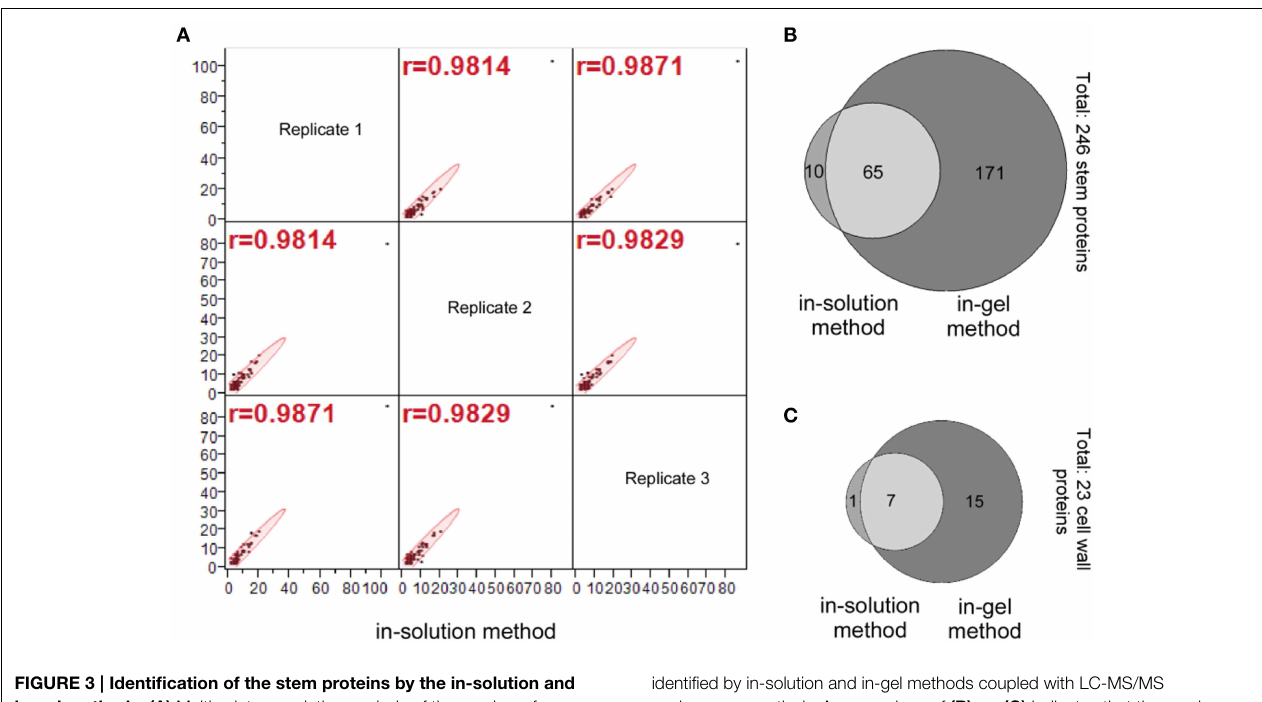
FIGURE 3 | Identification of the stem proteins by the in-solution and in-gel methods. (A) Multivariate correlation analysis of the number of peptide hits for the 75 stem proteins that identified by the in-solution method from analyzing the three replicate samples. (B) Venn diagram for the number of stem proteins, and (C) Venn diagram for the number of cell wall proteins